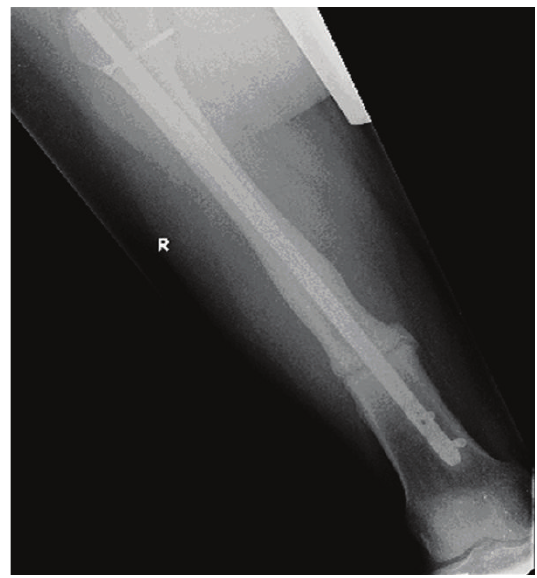
Figure 2: AP radiograph following corrective osteotomy of the right